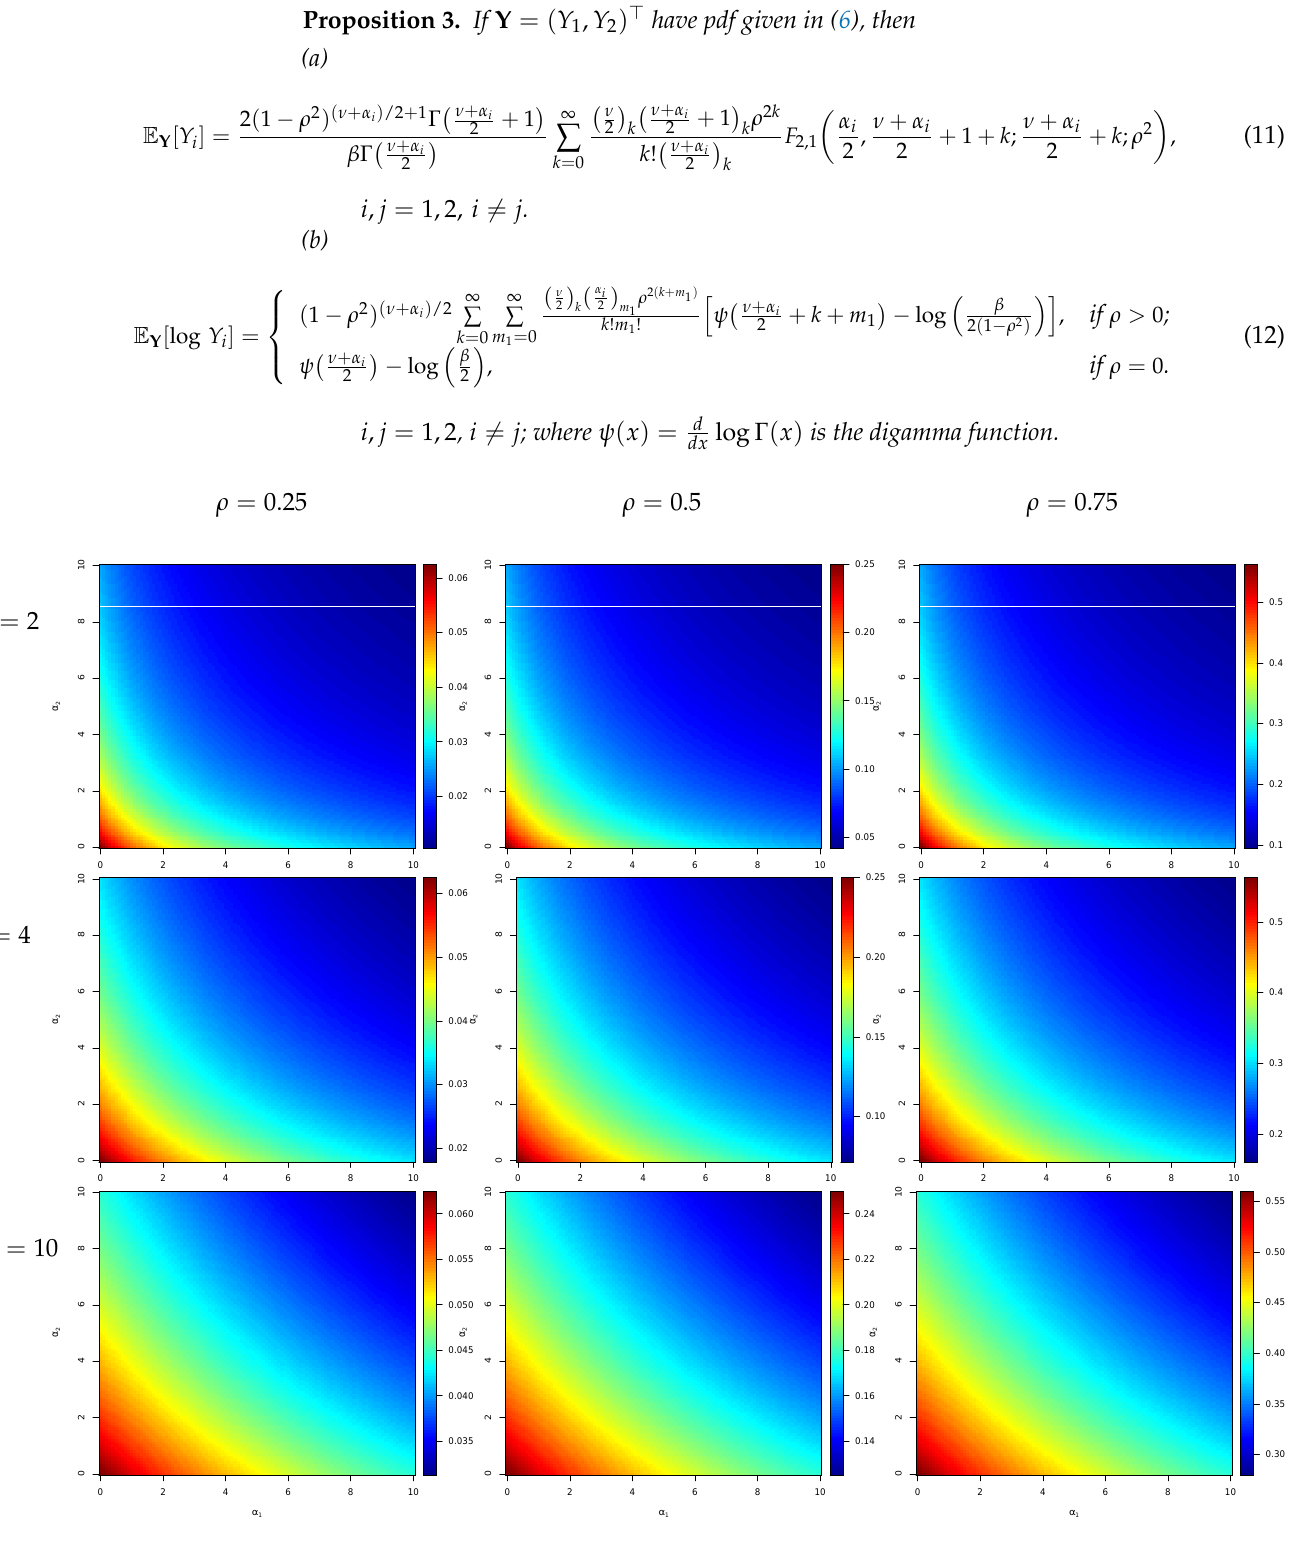
Figure 2. Correlation ρ Y of Corollary 1d for some parameter